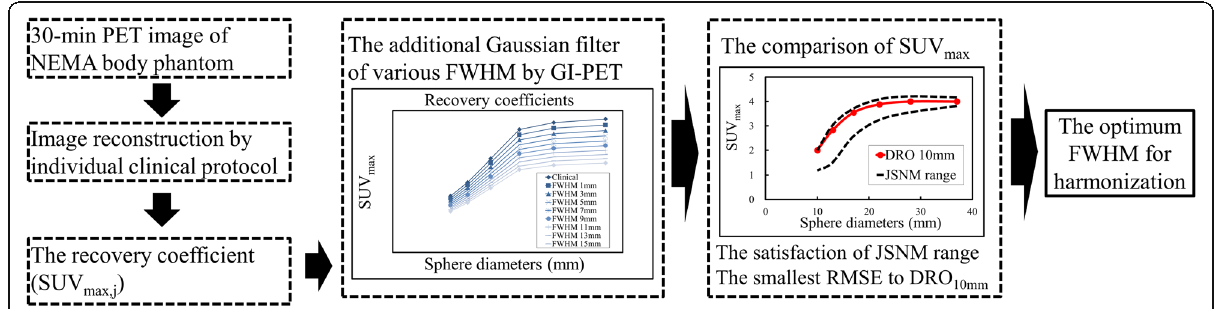
Fig. 2 Flow chart used to determine the optimal FWHM of additional Gaussian filter for